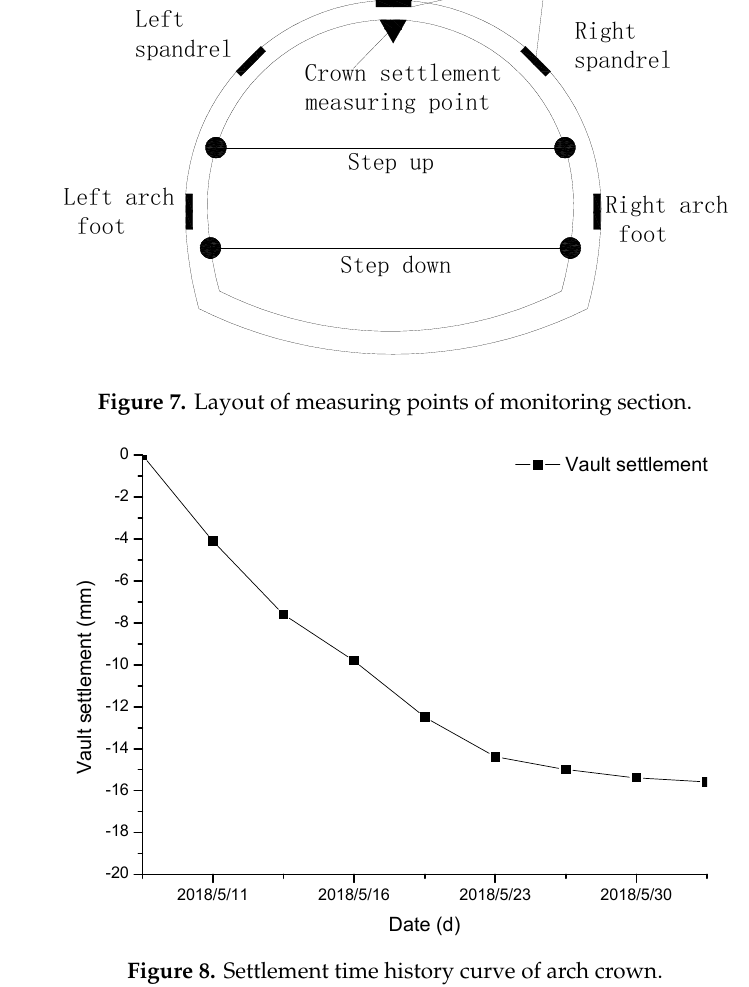
Figure 9. Time history curve of peripheral convergence.